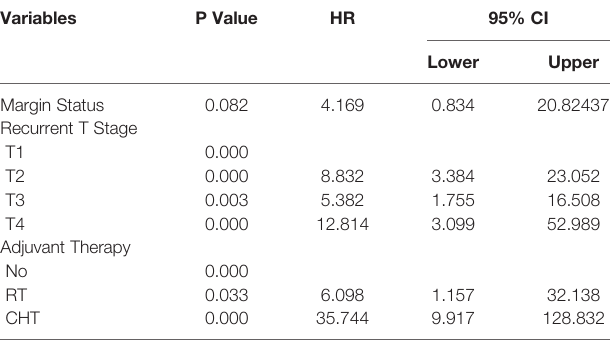
TABLE 3 | Cox multivariate regression analysis of disease free survival at 2